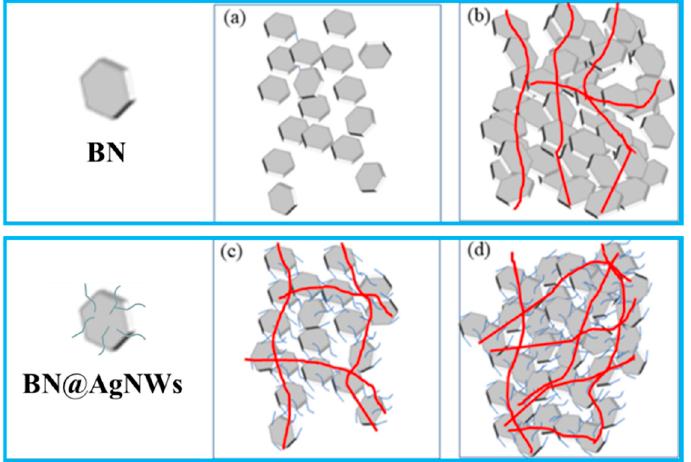
Figure 6. Schematic diagram of the dispersion of BN and BN@15AgNWs in PDMS matrix: ( a ) Low filler content BN/PDMS, ( b ) high filler content BN/PDMS, ( c ) low filler content BN@15AgNWs/PDMS, and ( d ) high filler content